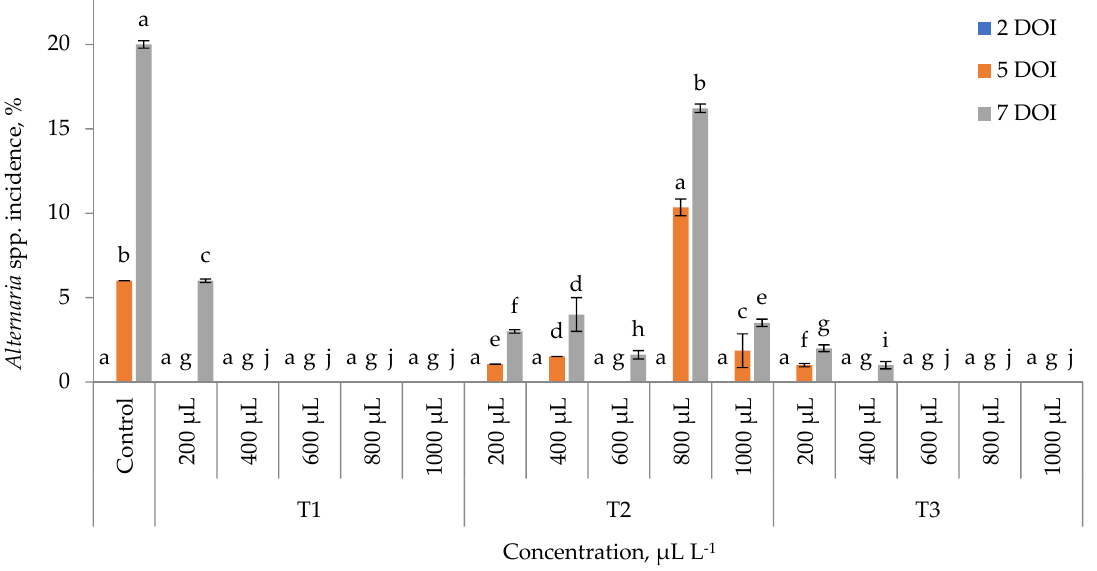
presented in Figure 3. Evaluating the effect of T1 concentrations from 200 to 1000 µ L L − 1 , no colonies of Alternaria spp. were observed at 2 and 5 DOI. However, 6% incidence was reached at 7 DOI under 200 µ L L − 1 .